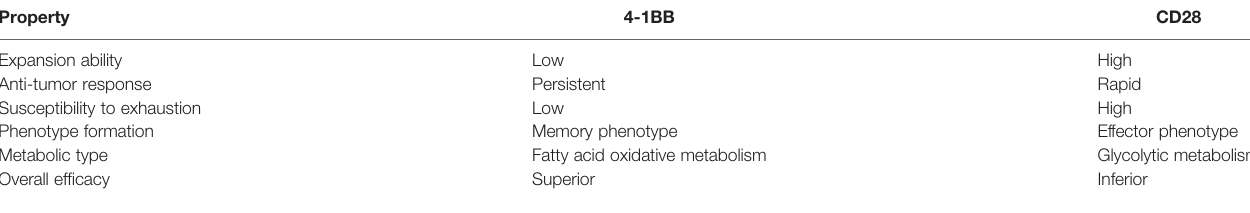
TABLE 1 | Comparison of properties of different costimulation 4-1BB versus CD28 in CAR-T cell.